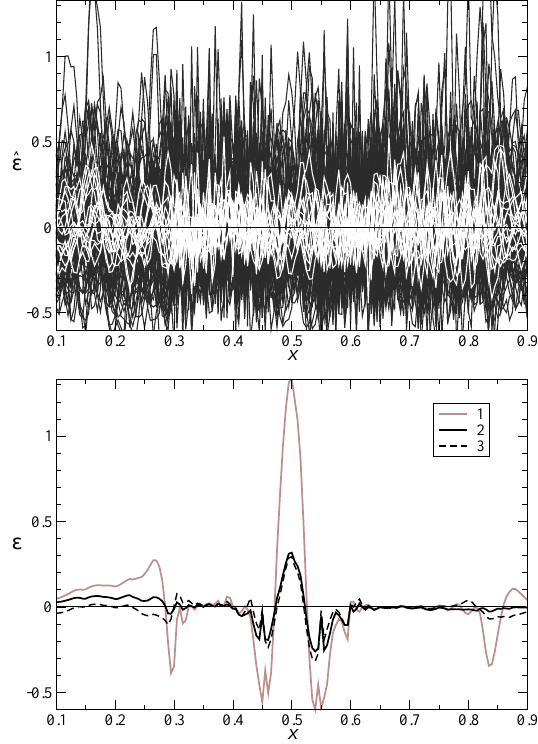
Fig. 4. Up: the sample relative error ˆ ε . Set of ˆ ε for L = 25 - dark envelope and set of ˆ ε for L = 100 - white envelope. Down: the relative error ε by the inverse Hessian - line 1, and by the EIH methods with L = 100: method 2a - line 2; method 2b - line 3.